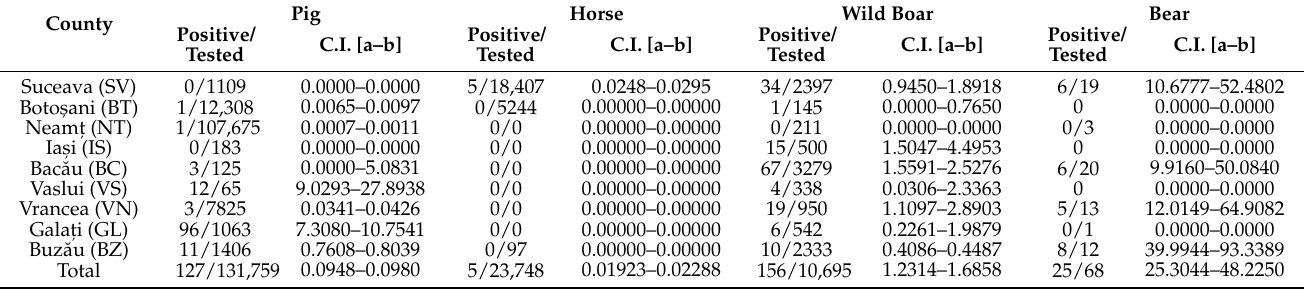
Table 2. Geographical distribution of Trichinella infection in animals in North-Eastern